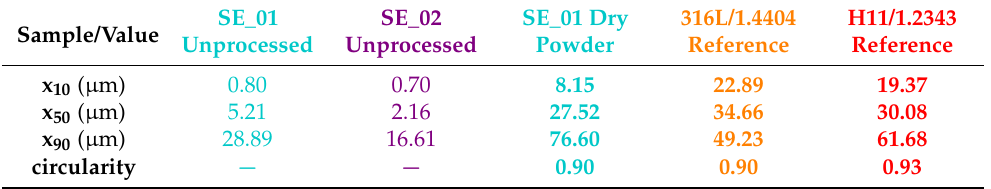
Table 4. x 50 and circularity values for die-sink EDM particles and both AM reference